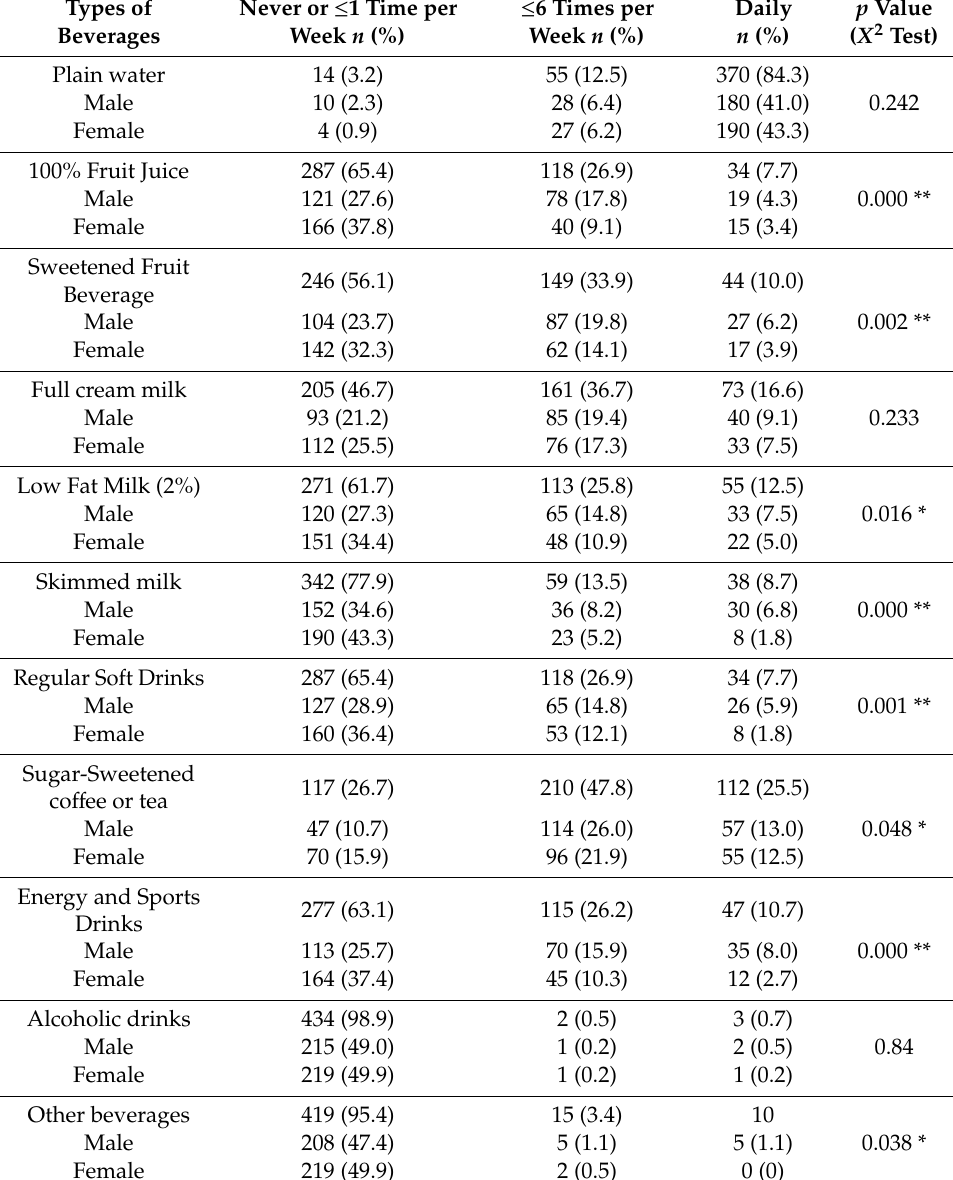
Table 3. Frequency of beverages consumption ( n =